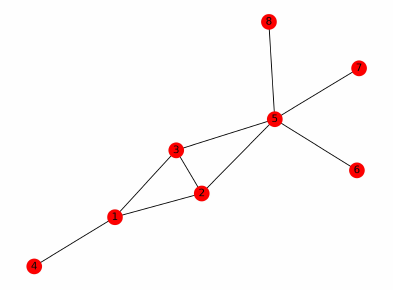
Figure 1. Example of an undirected